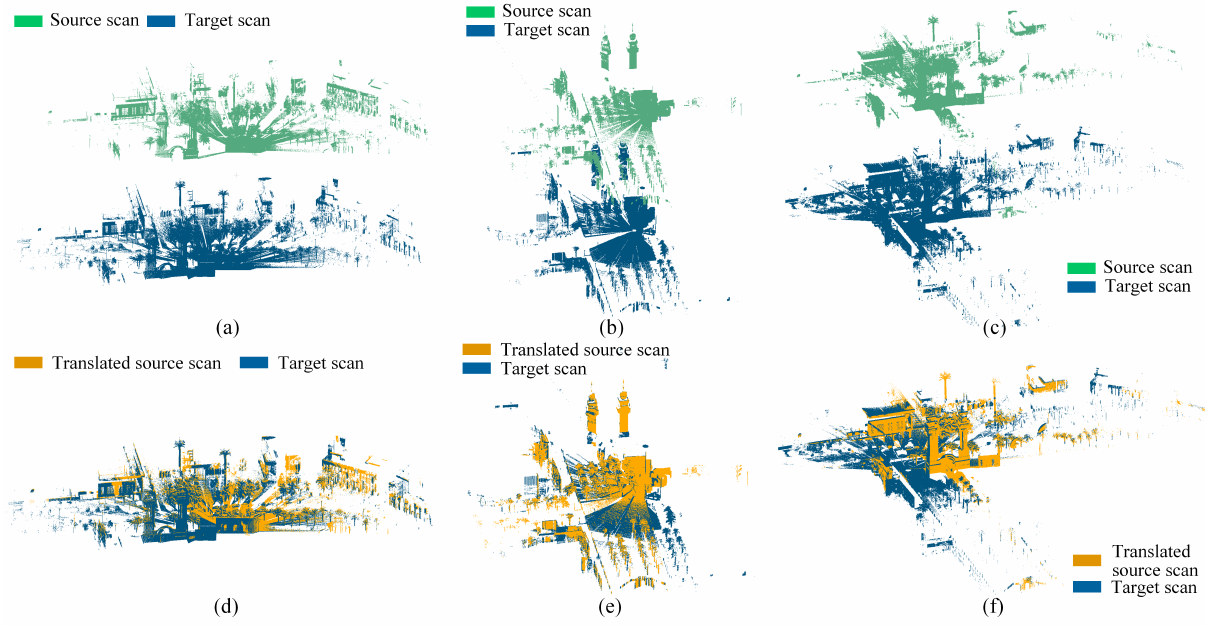
Figure 5. Data and results of Resso dataset. (a), (b) and (c) source and target point clouds. (d), (e), and (f) matching results.